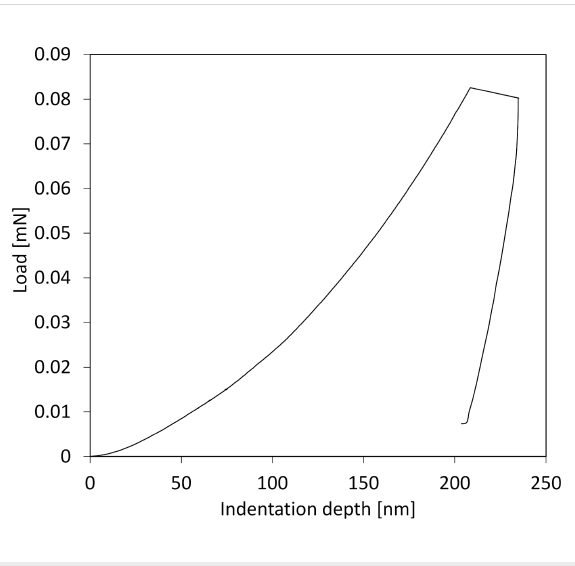
Figure 3: Load-vs-displacement curve taken by nanoindentation with a Berkovich indenter tip on a polyurethane sample showing negative stiffness, seen as the outward bulging of the curve, which develops in the unloading (right branch) of the curve, because of